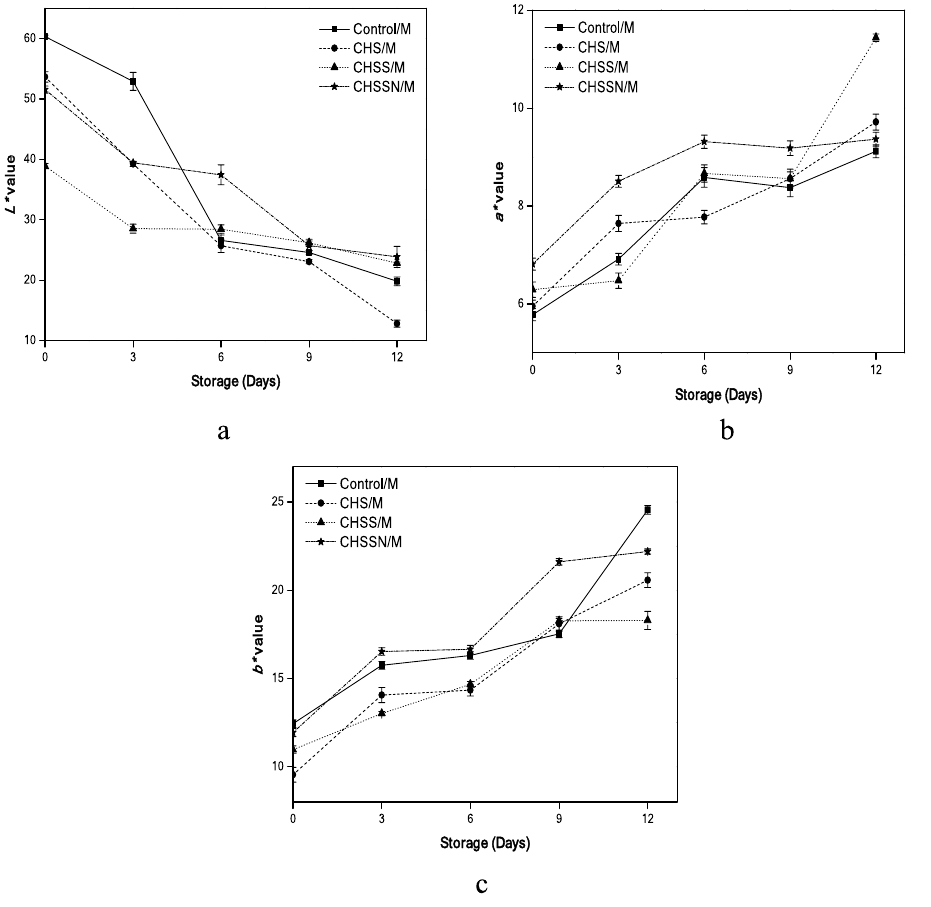
Figure 2. Effects of nano-coating treatments on color index profile L * ( a ), a * ( b ), and b * ( c